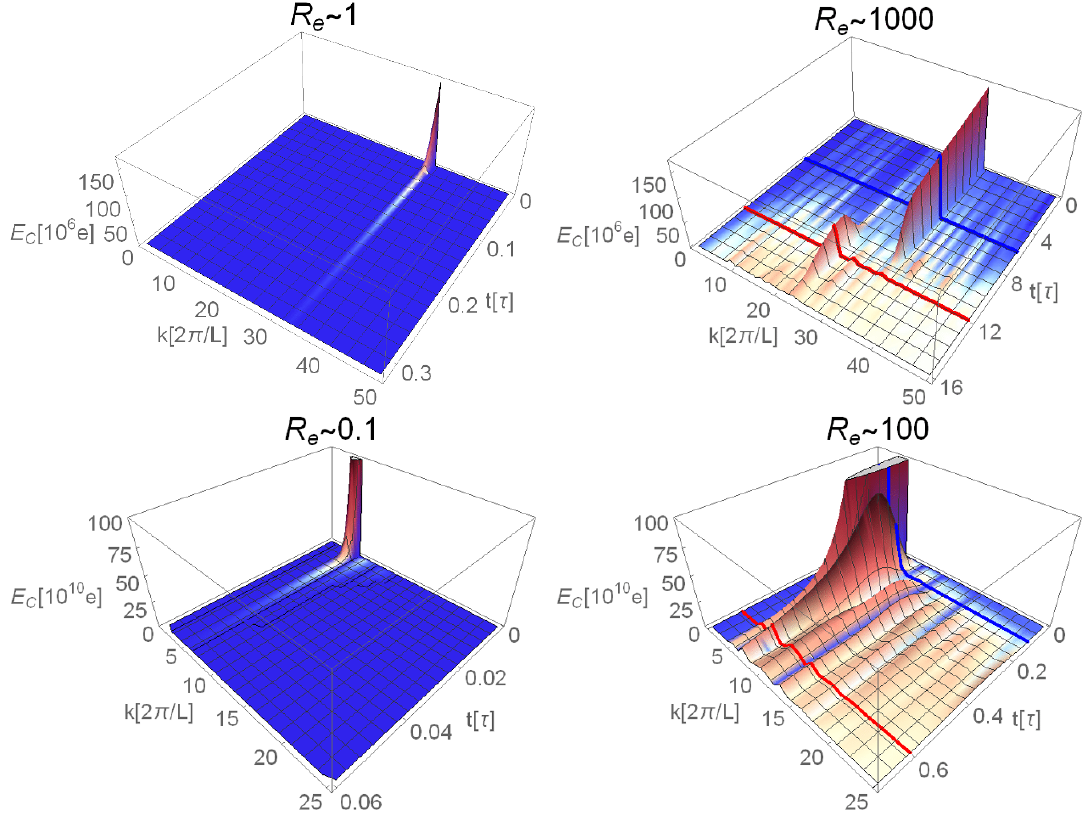
Figure 3 . The energy spectrum E C for two dimensional and three dimensional (cid:13)uid (cid:13)ow (top row and bottom row, respectively). At low Reynolds number (left column) we (cid:12)nd that E C decays quickly into an equilibrated phase. For two dimensional (cid:13)ow and high Reynolds number (top right) we (cid:12)nd that instabilities with lower wavenumber grow and dominate the (cid:13)ow. In three dimensional (cid:13)ow with large Reynolds number (bottom right) turbulent instabilities develop at large wave numbers. A detailed energy spectrum at times marked by the red and blue lines can be found in (cid:12)gures 4 and